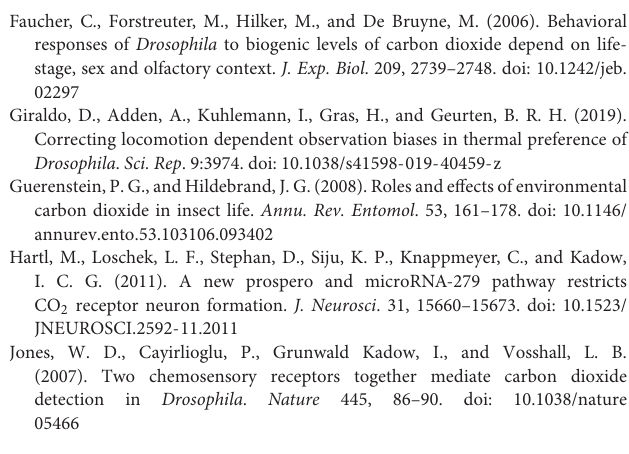
Supplementary Figure 1 | (A) Response of ato-/- flies to CO 2 -free air. IR mutant ato-/- flies did not differ in their response to CO 2 -free air over the atmospheric